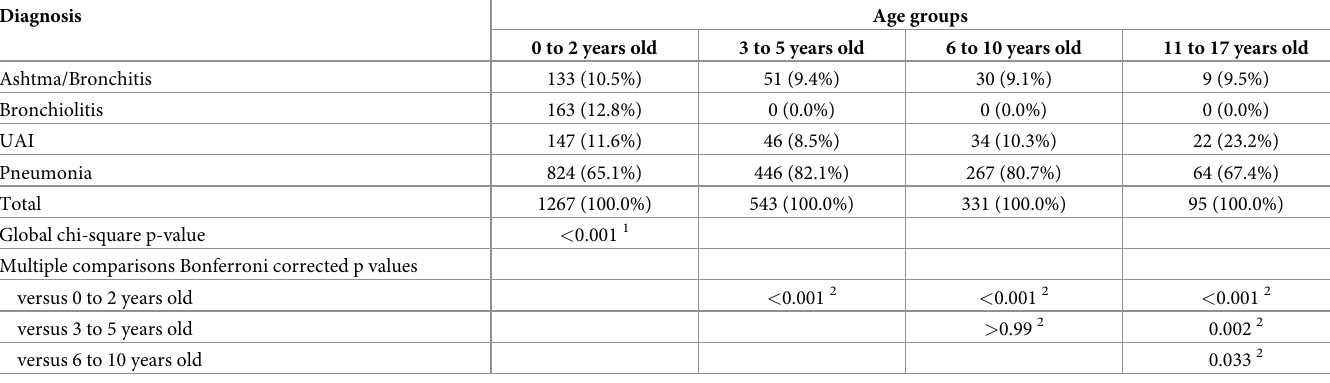
Table 3. Relationship between diagnosis and age groups (n =